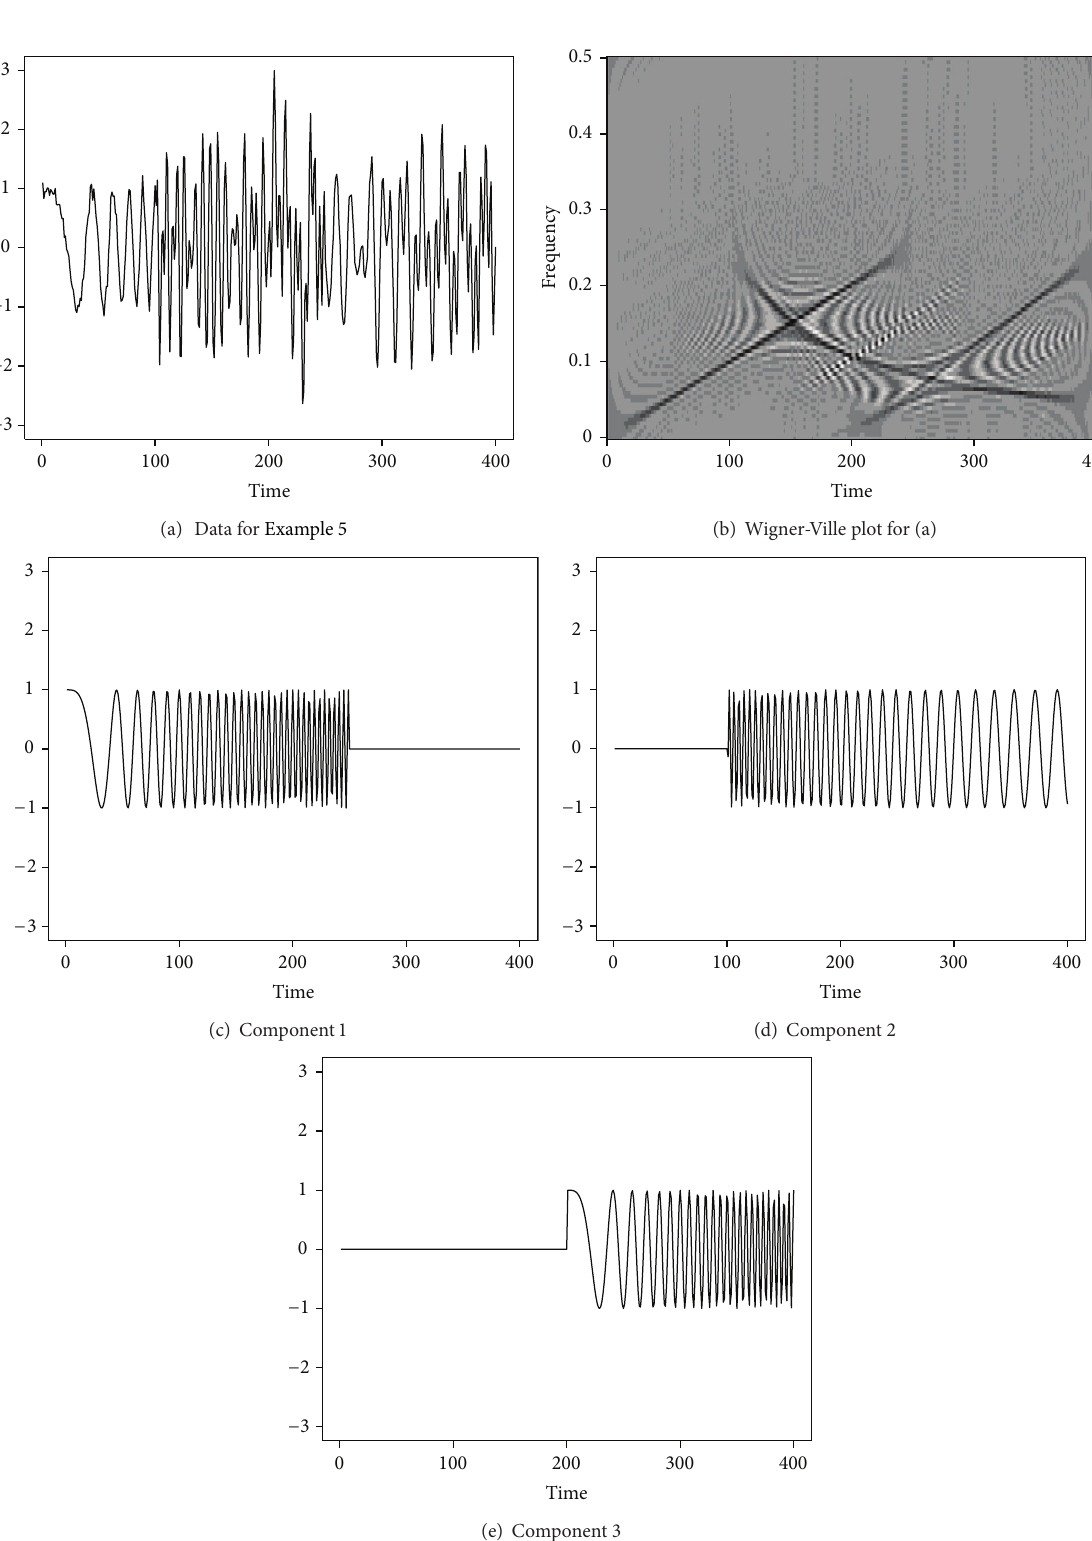
Figure 8: (a) A realization of the process in Example 5; (b) the Wigner-Ville time-frequency distribution of the data; (c), (d), and (e) the three